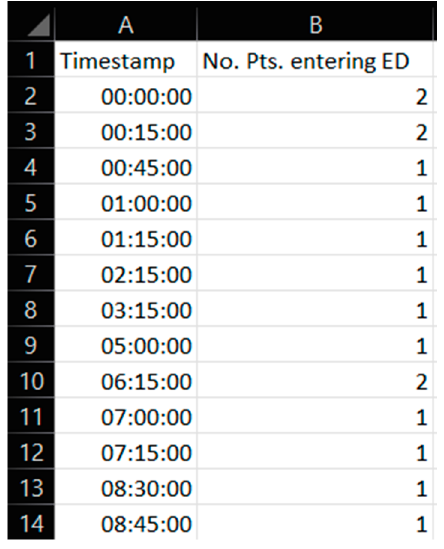
Figure 2. Screen capture from Meona showing patient arrival time